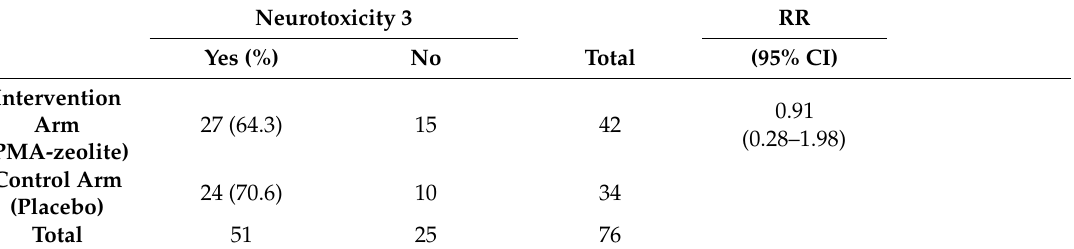
Table 3. Univariate and multivariate